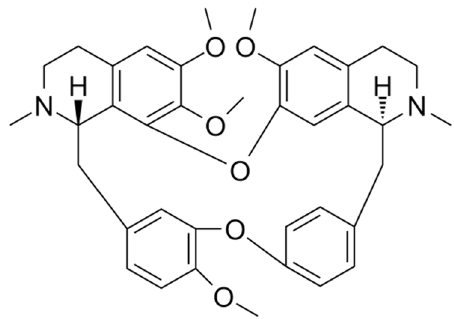
Figure 3. Chemical structure of tetrandrine.